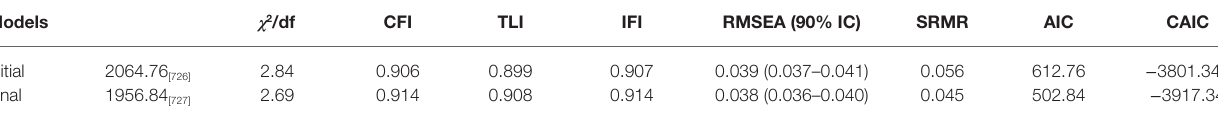
TABLE 2 | Goodness of fit. Models